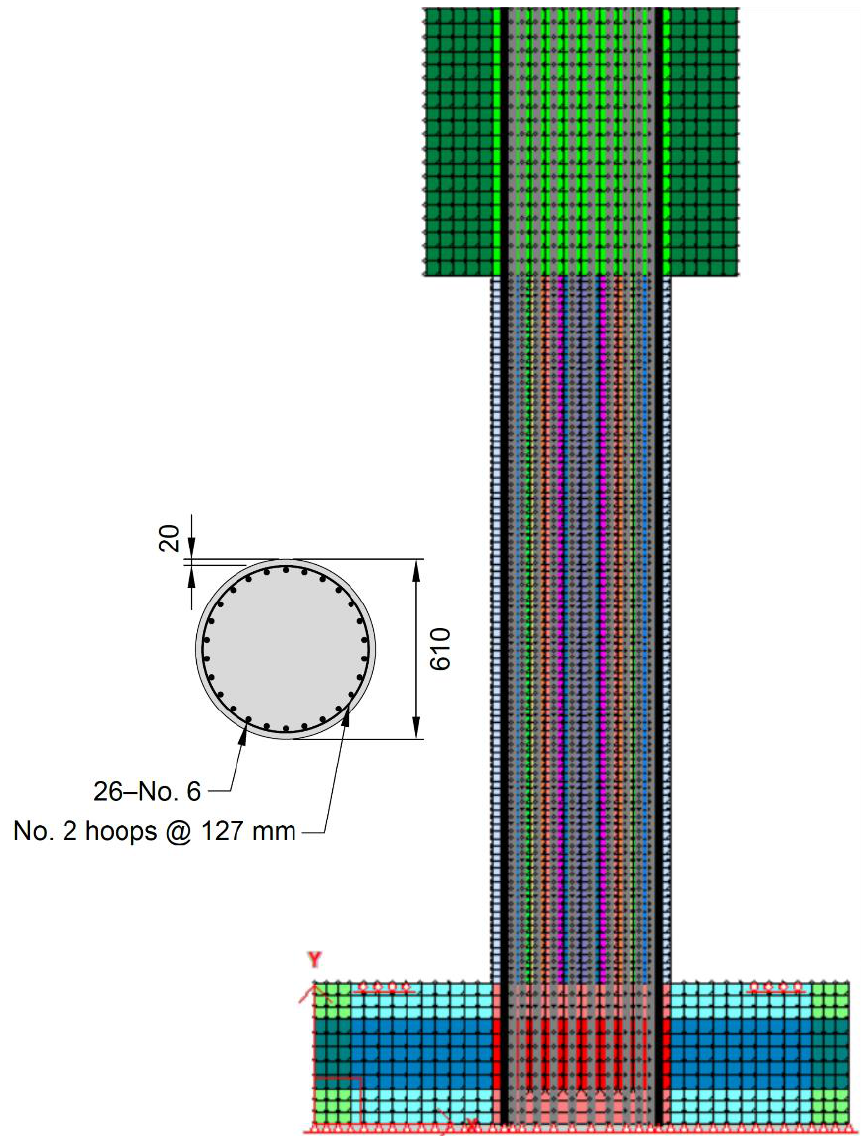
Figure 8. Example of finite element model and typical cross-section of columns tested by Verma et al. [22].